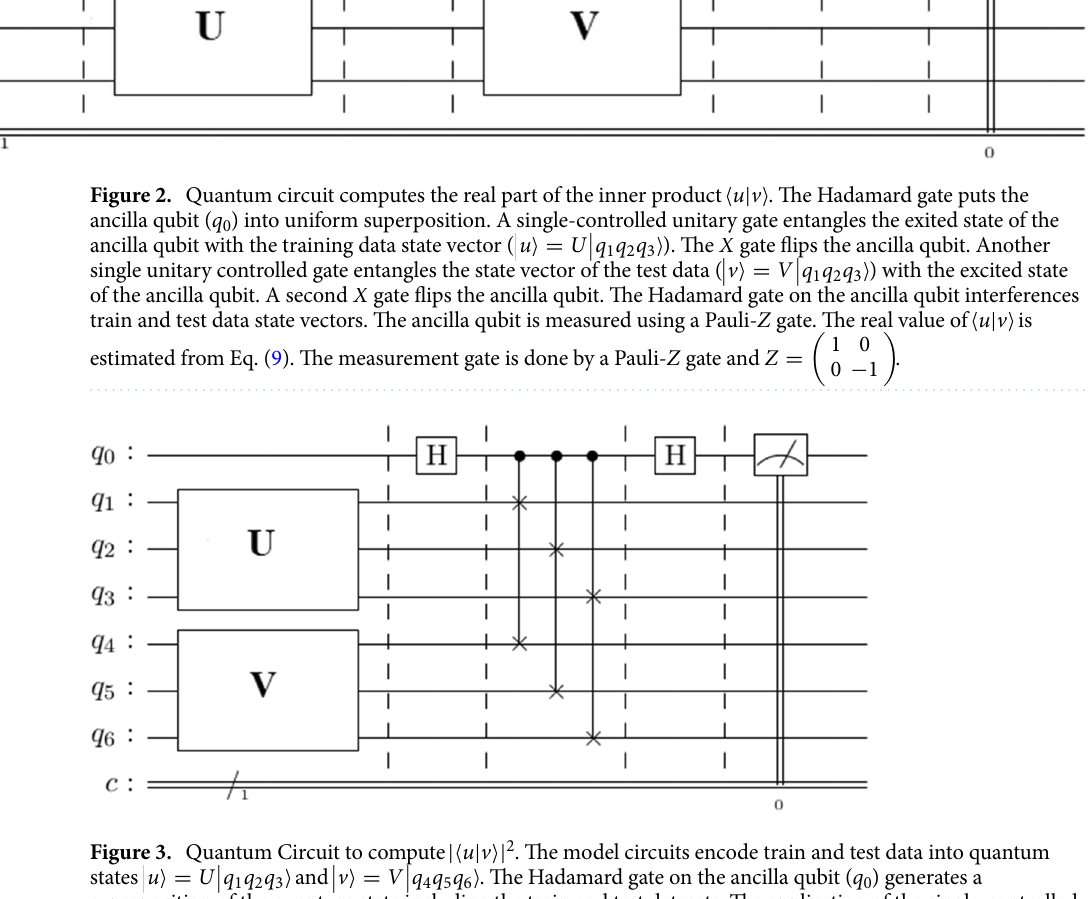
0 state is measured in the Z basis. | �